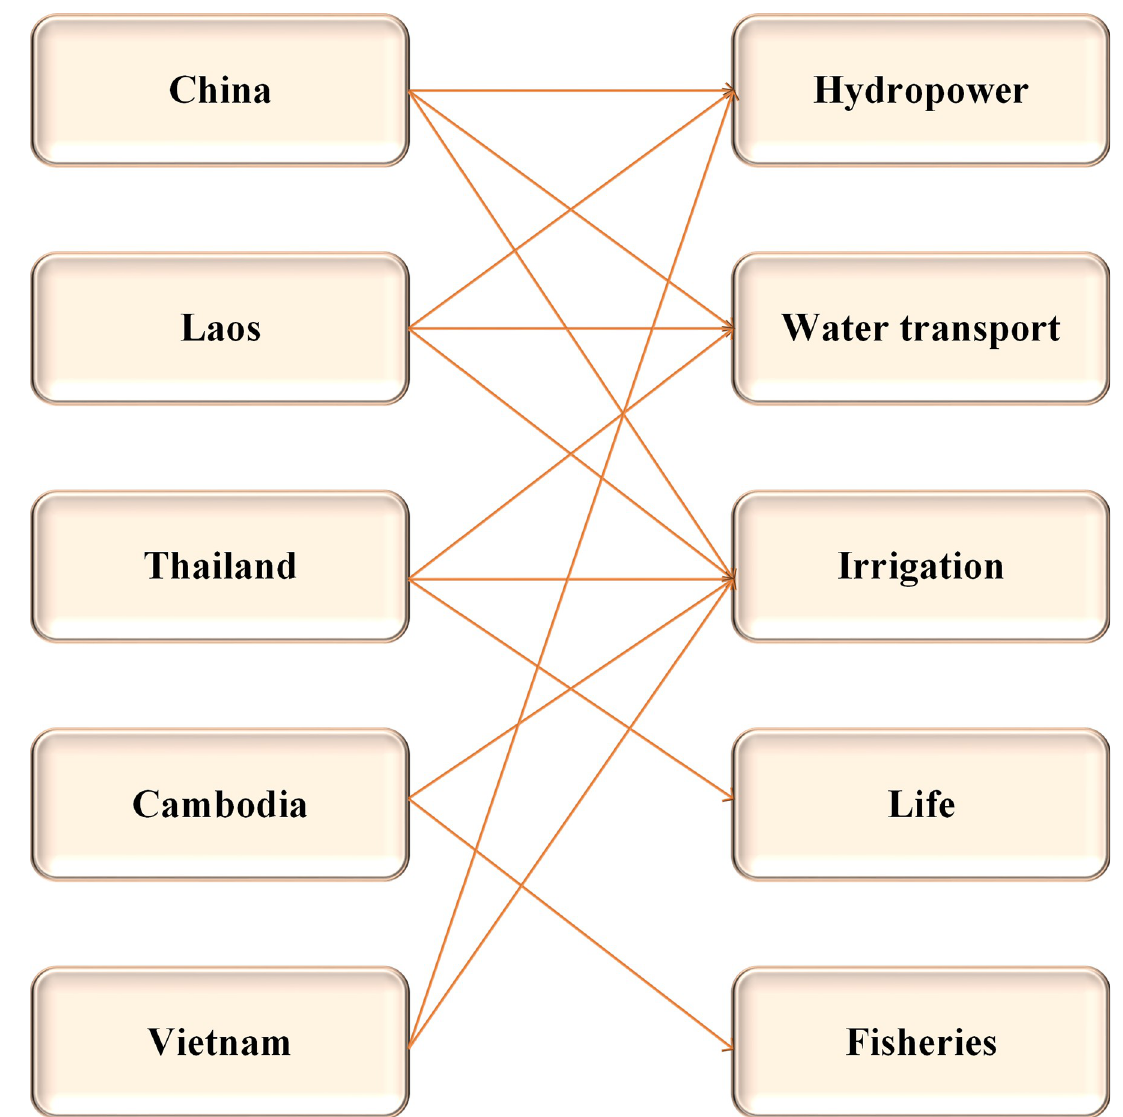
Fig 5. Comparison of GDP or water use income among basin